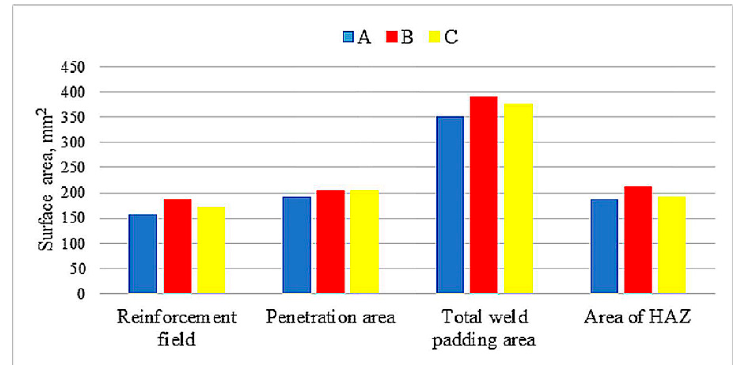
Figure 9. Surface areas of individual zones in the weld layer cross-sections.